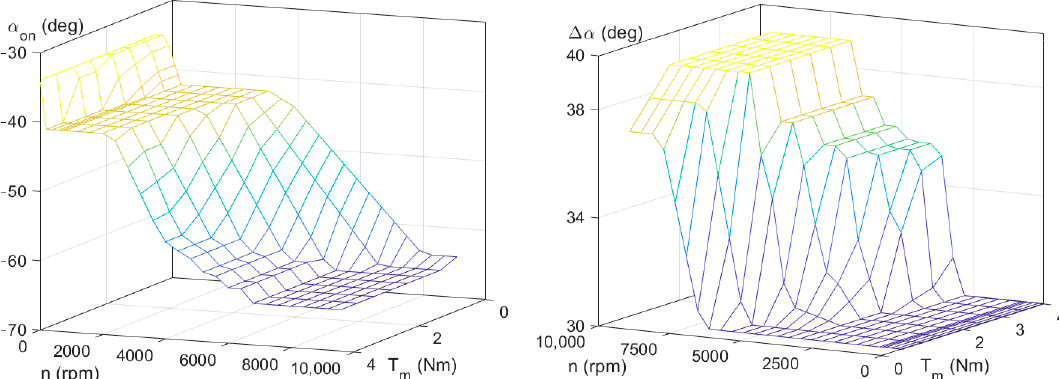
Figure 7. Dependence of the switch-on angle α on on rotational speed n and torque T m , and the phase supply angular range ∆ α on rotational speed n and torque T m .